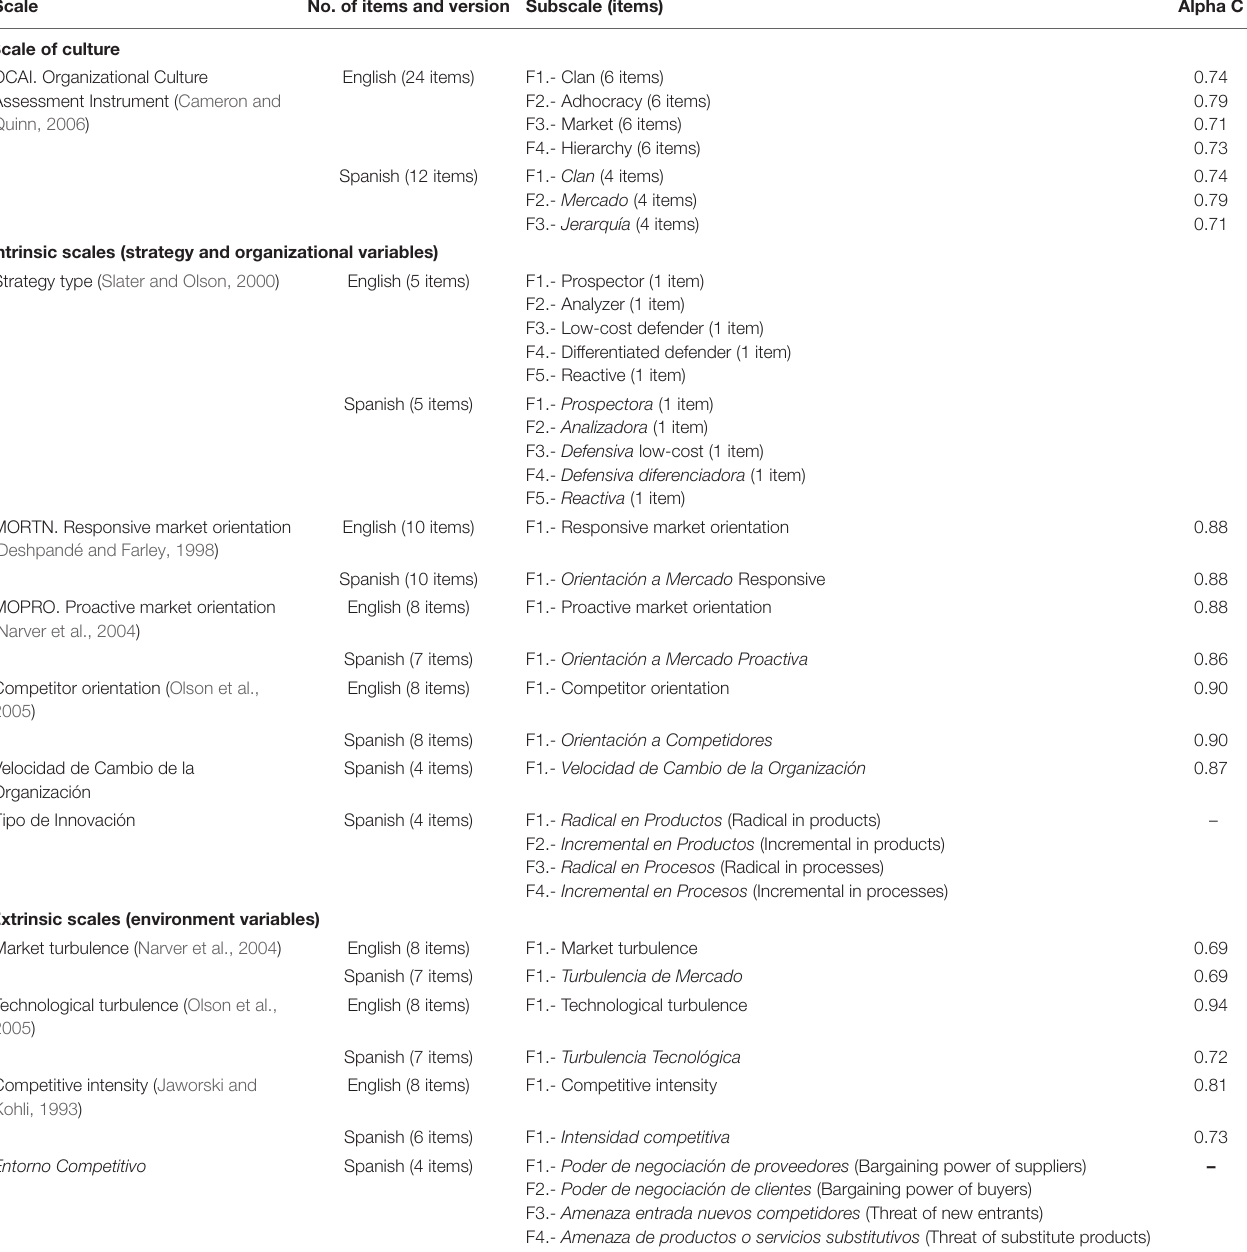
TABLE 1 | Summary of the